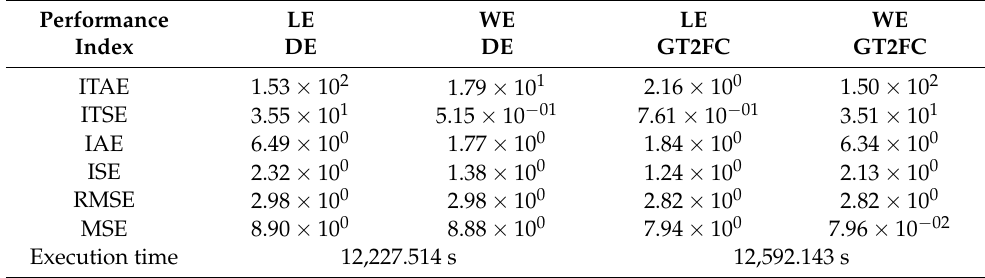
Table 4. Performance index results without